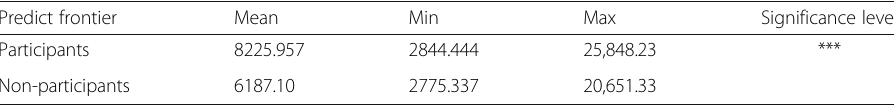
Table 7 Predicted frontier output after bias